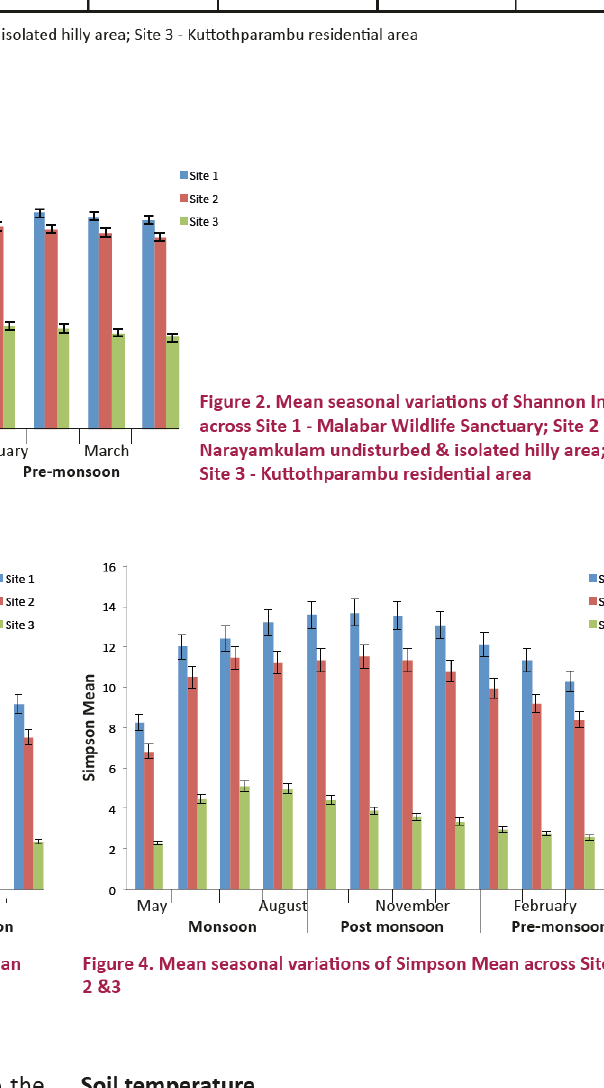
Ffigure 2. Mean seasonal varfiafions of Shannon Index across Sfite 1 - Malabar Wfildlfife Sanctuary; Sfite 2 -